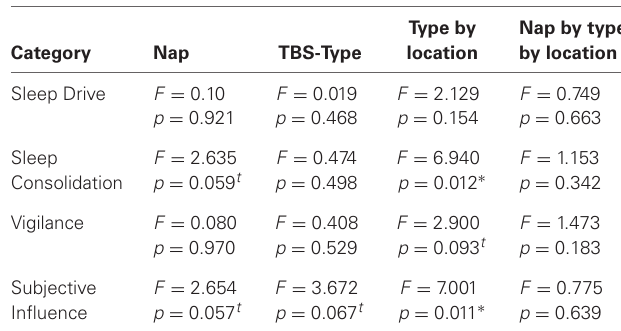
Table 1 | Statistical overview: effects of stimulation on categorical measures